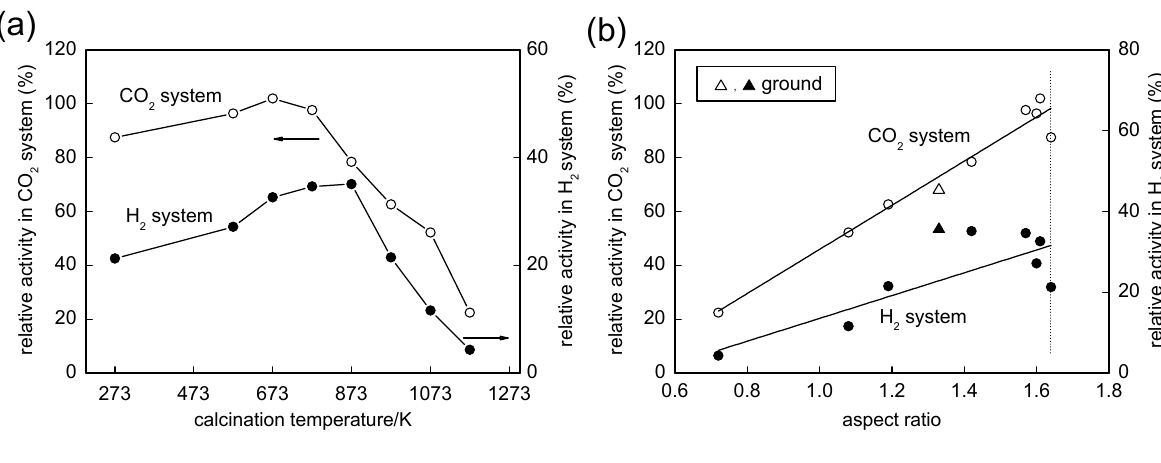
Figure 5. ( a ) Correlation between photocatalytic activity and calcination temperature (data of the original uncalcined sample shown at “273 K”); ( b ) Photocatalytic activities as functions of aspect ratio (AR). Plots for the original uncalcined sample are on a dotted line. Open (CO 2 ) and closed (H 2 ) triangles are of the ground